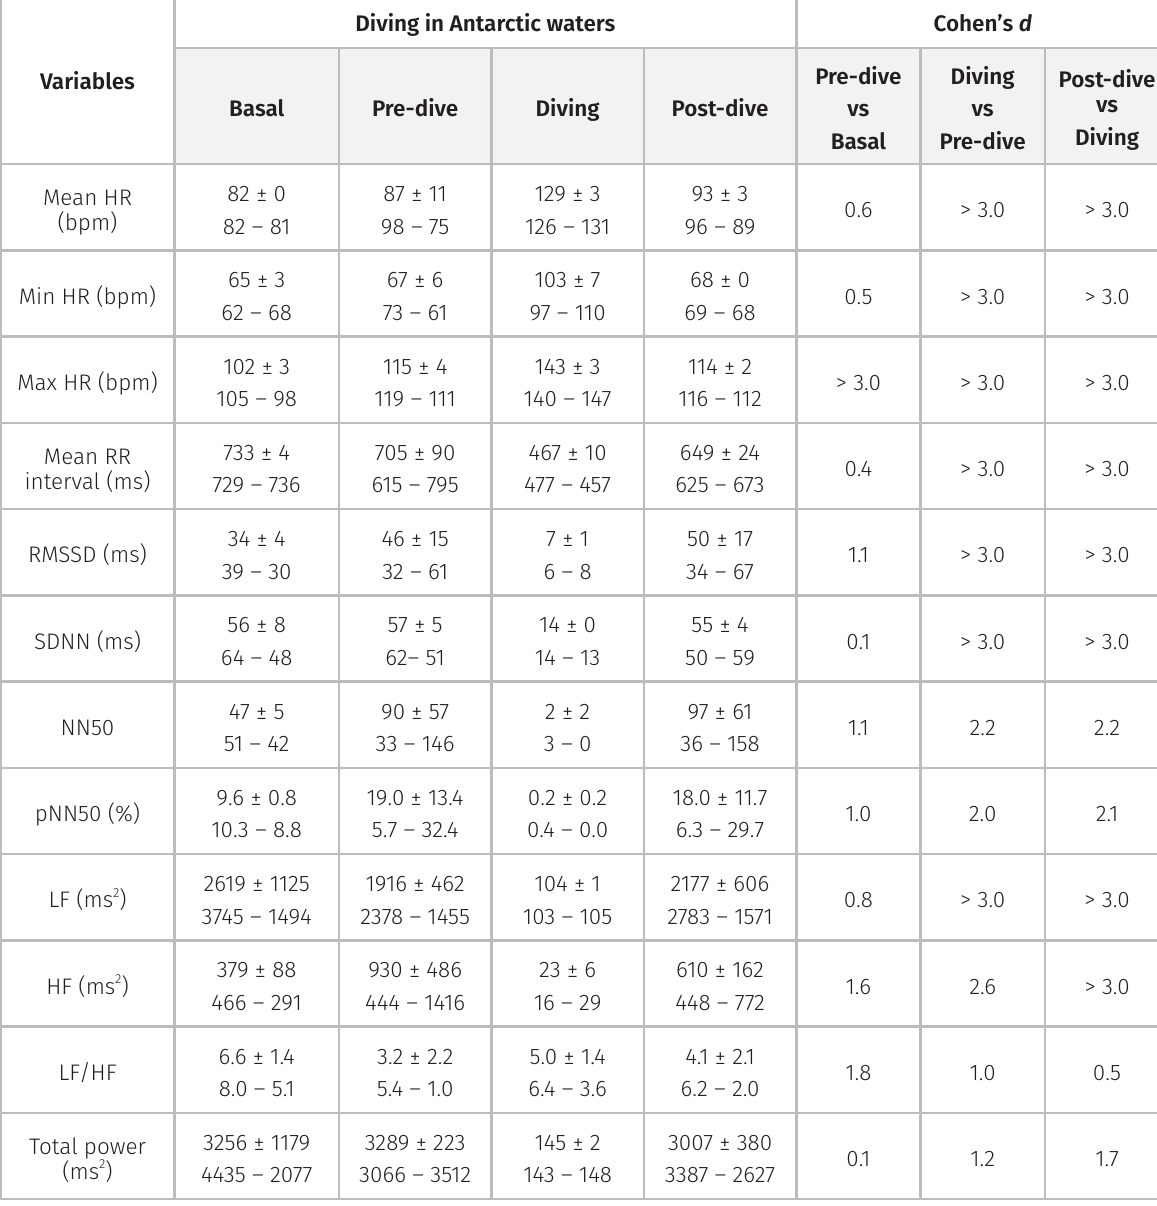
Table III. Heart rate variability (HRV) parameters measured at four time points (baseline, pre-dive, diving, and post-dive) in the Diving group